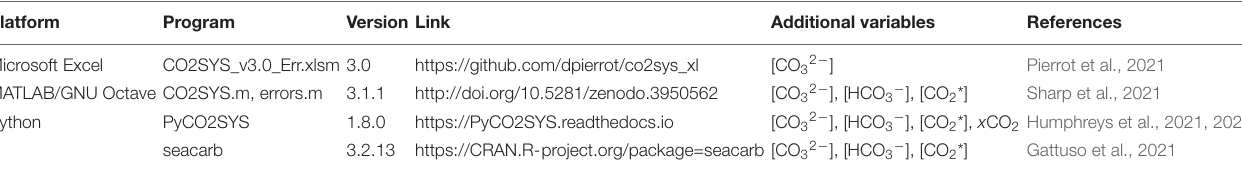
TABLE 4 | Updated programs that are being released in this